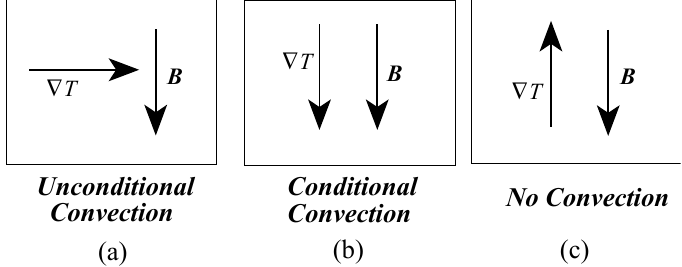
Figure 1. The effect of the relative orientation of the temperature gradient with respect to the body force on the setup of convection. ( a ) Unconditional convection; ( b ) conditional convection; ( c ) no convection.